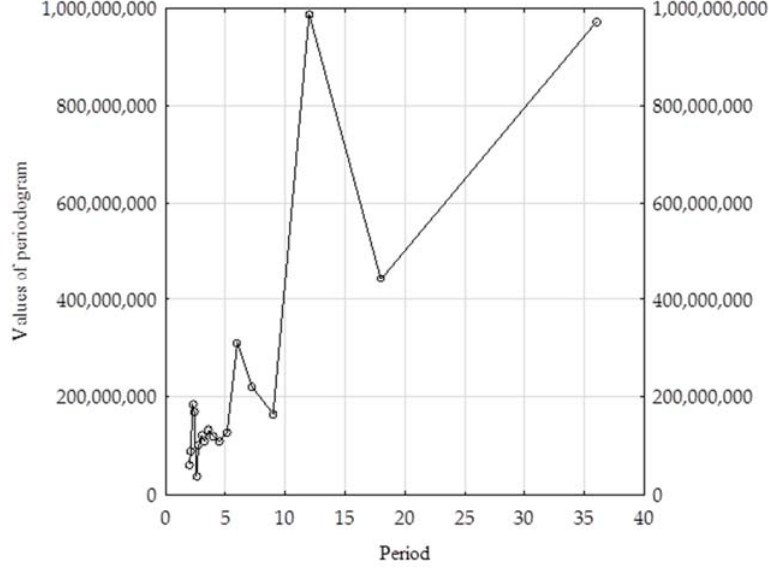
Figure 5. Periodogram of the monthly averages of the daily sewage outflow from the urban agglomeration of Radom.